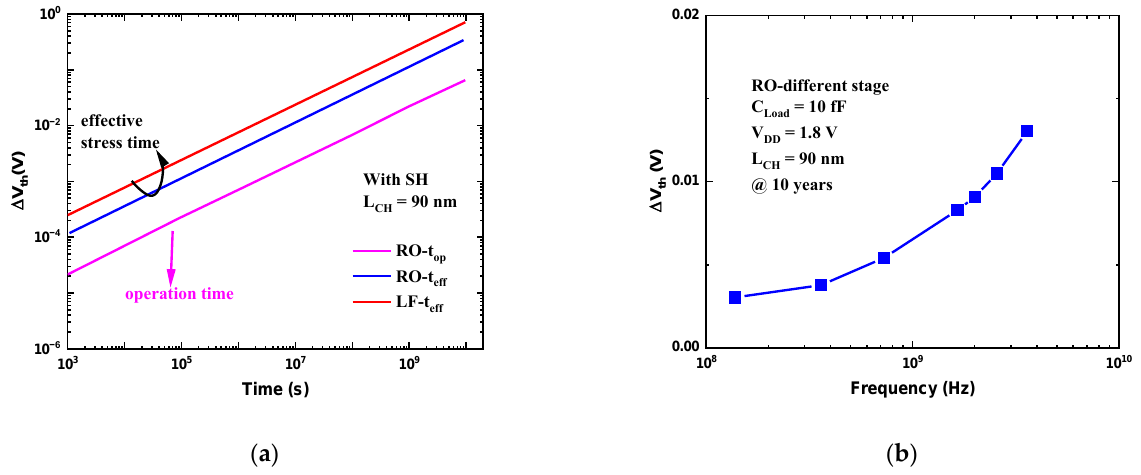
Figure 6. ( a ) Predicted ∆ V th time evolution for a low-frequency (LF) MG-FET under HCI stress and in RO circuit; ( b ) the TVS of FinFET as a function of frequency after 10 years’ operation in RO circuits [28].